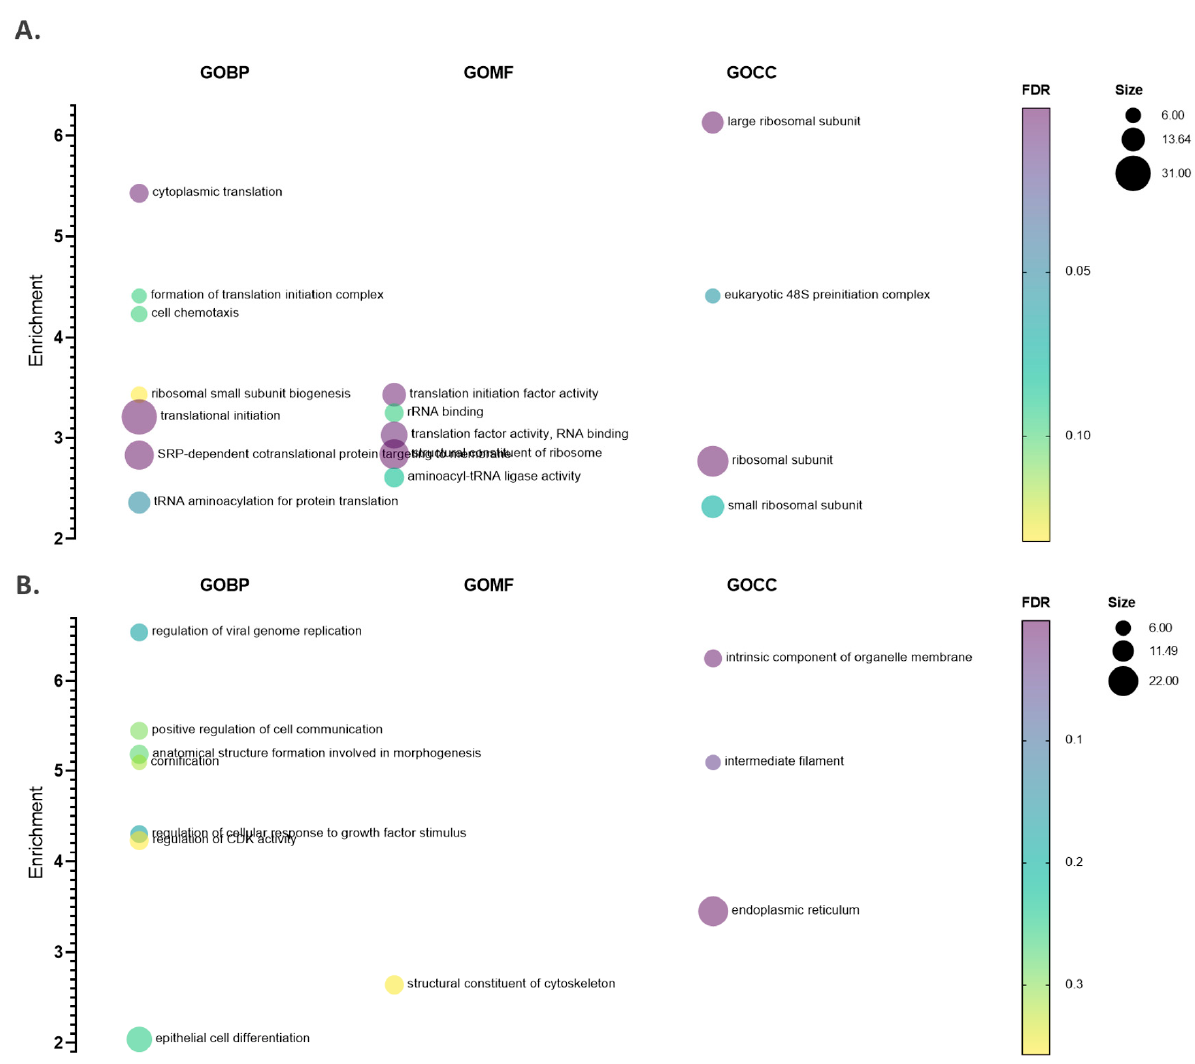
Figure 5. Multiple variable bubble plot representations of significantly enriched gene ontology (GO) terms. Enriched GO terms (biological process (BP), molecular function (GOMF) and cellular component (GOCC), 1335 genes) with a minimum 2-fold enrichment are shown for the si CTR ( A ) and si NatA ( B ) setup. Term enrichment was determined using GOrilla [50] and p values were corrected for multiple hypotheses testing using the Benjamini and Hochberg false discovery rate (FDR) (Table S4). Only non-redundant terms with at least 5 members and corrected p values < 0.2 were considered. The bubble size corresponds to the number of regulated proteins with a given GO term and the colour code represents the p -value scale.